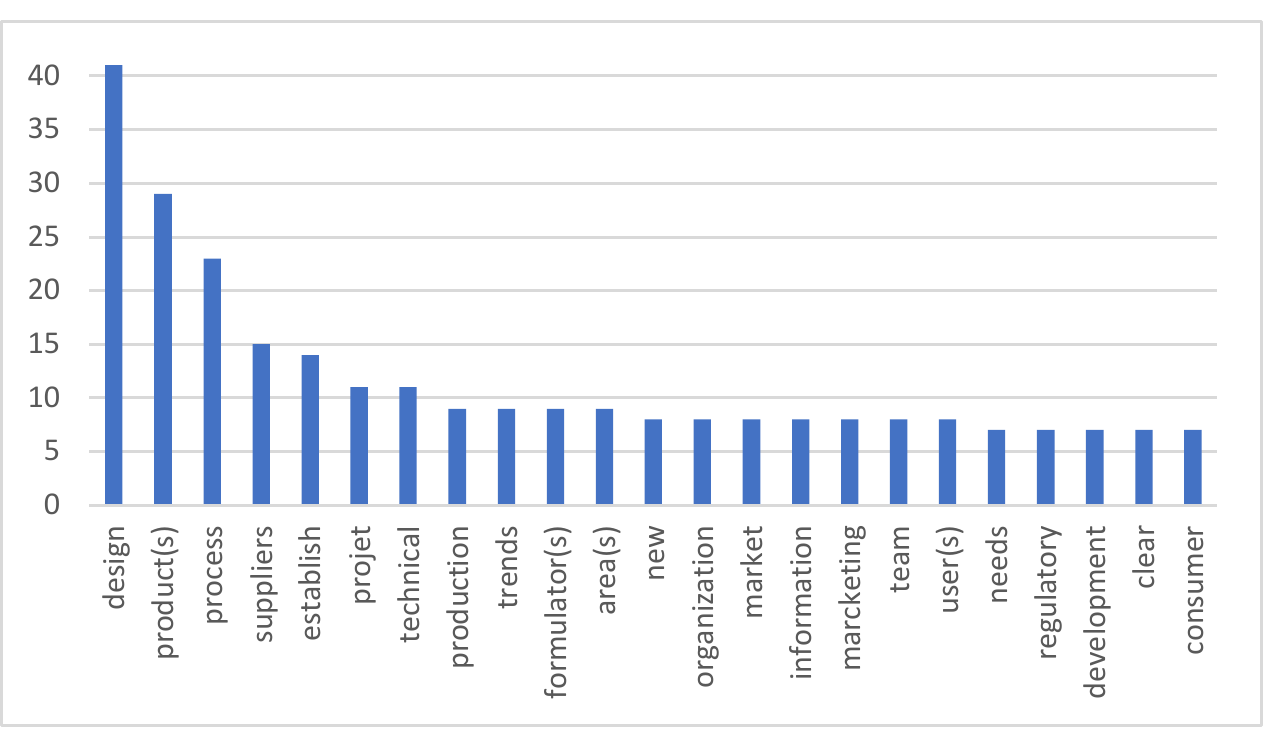
Figure 7. The 20 most repeated words in recommendations and their frequency within the knowledge base.